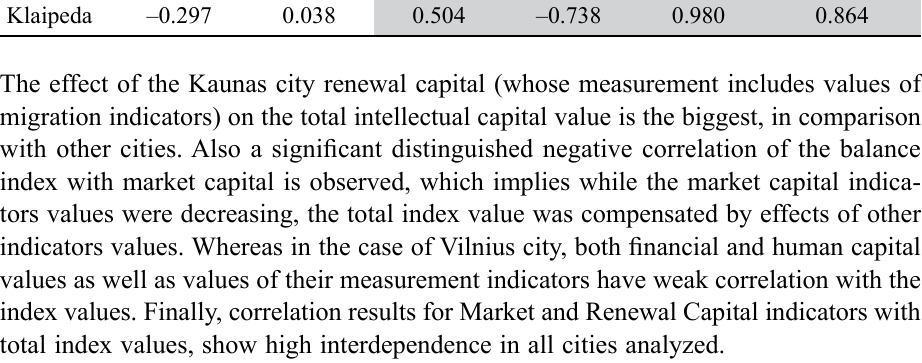
RC, migration excluded